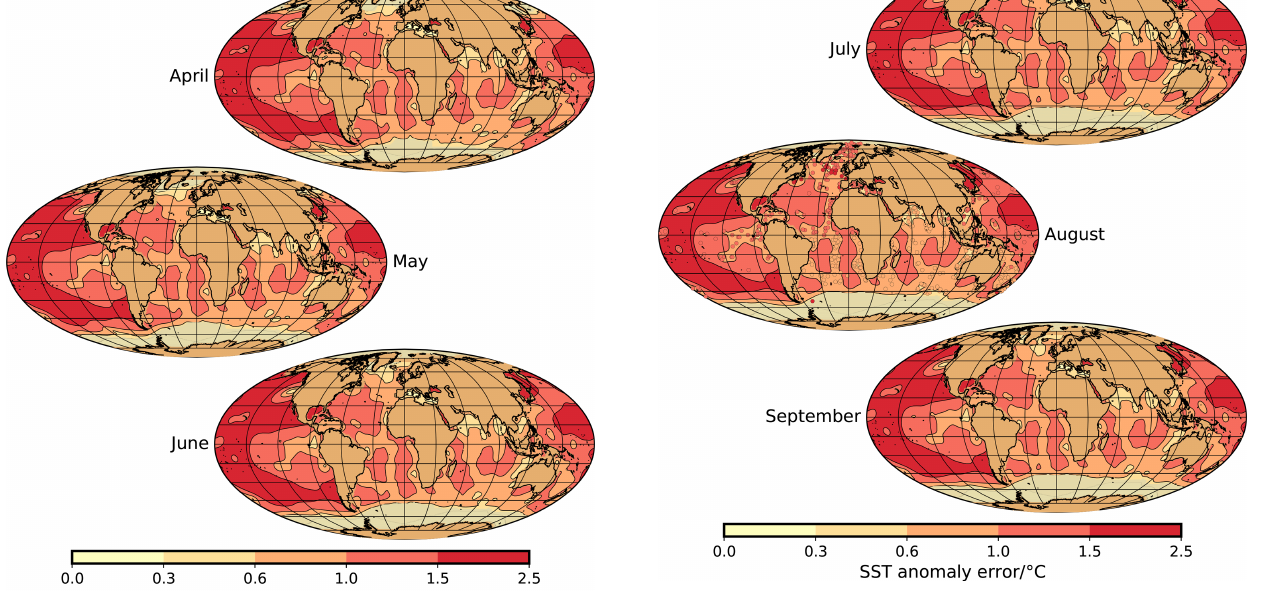
Figure A5. Uncertainty of NSST anomaly (contour map) and sea- ice extent (yellow–brownish areas close to Antarctica and in the Arctic; see Fig. A4) for April, May, and June.